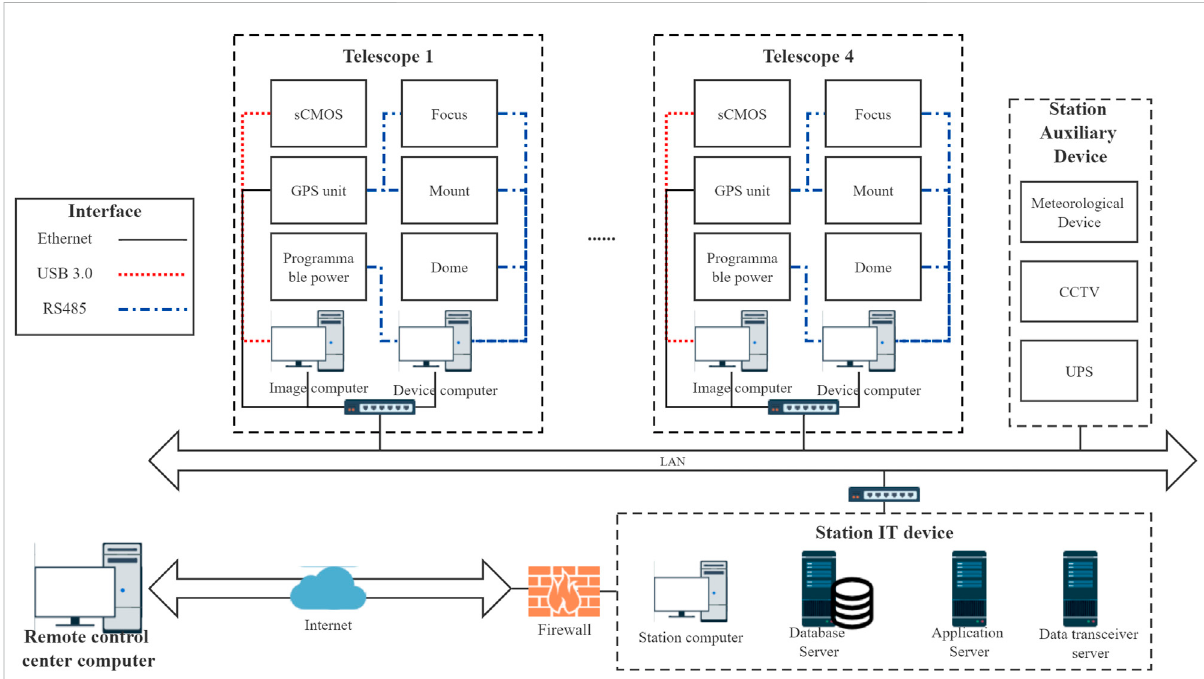
FIGURE 2 Hardware layout of Korla observatory. There are four 36 cm telescopes deployed at this modest observation site. The network port, USB 3.0, andRS485areutilizedtoconnecteachcomponentofthetelescopeasawhole(includingtheopticaltube,mount,sCMOScamera,dome,andother additional components). Finally, the observatory ’ s lone communication outlet is linked to the remote control center through the